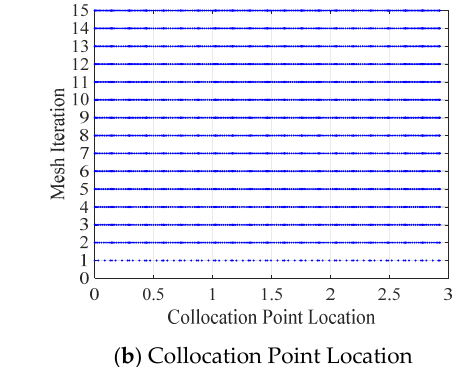
mesh each time the mesh was redefined according to the concept shown in Figure 15.